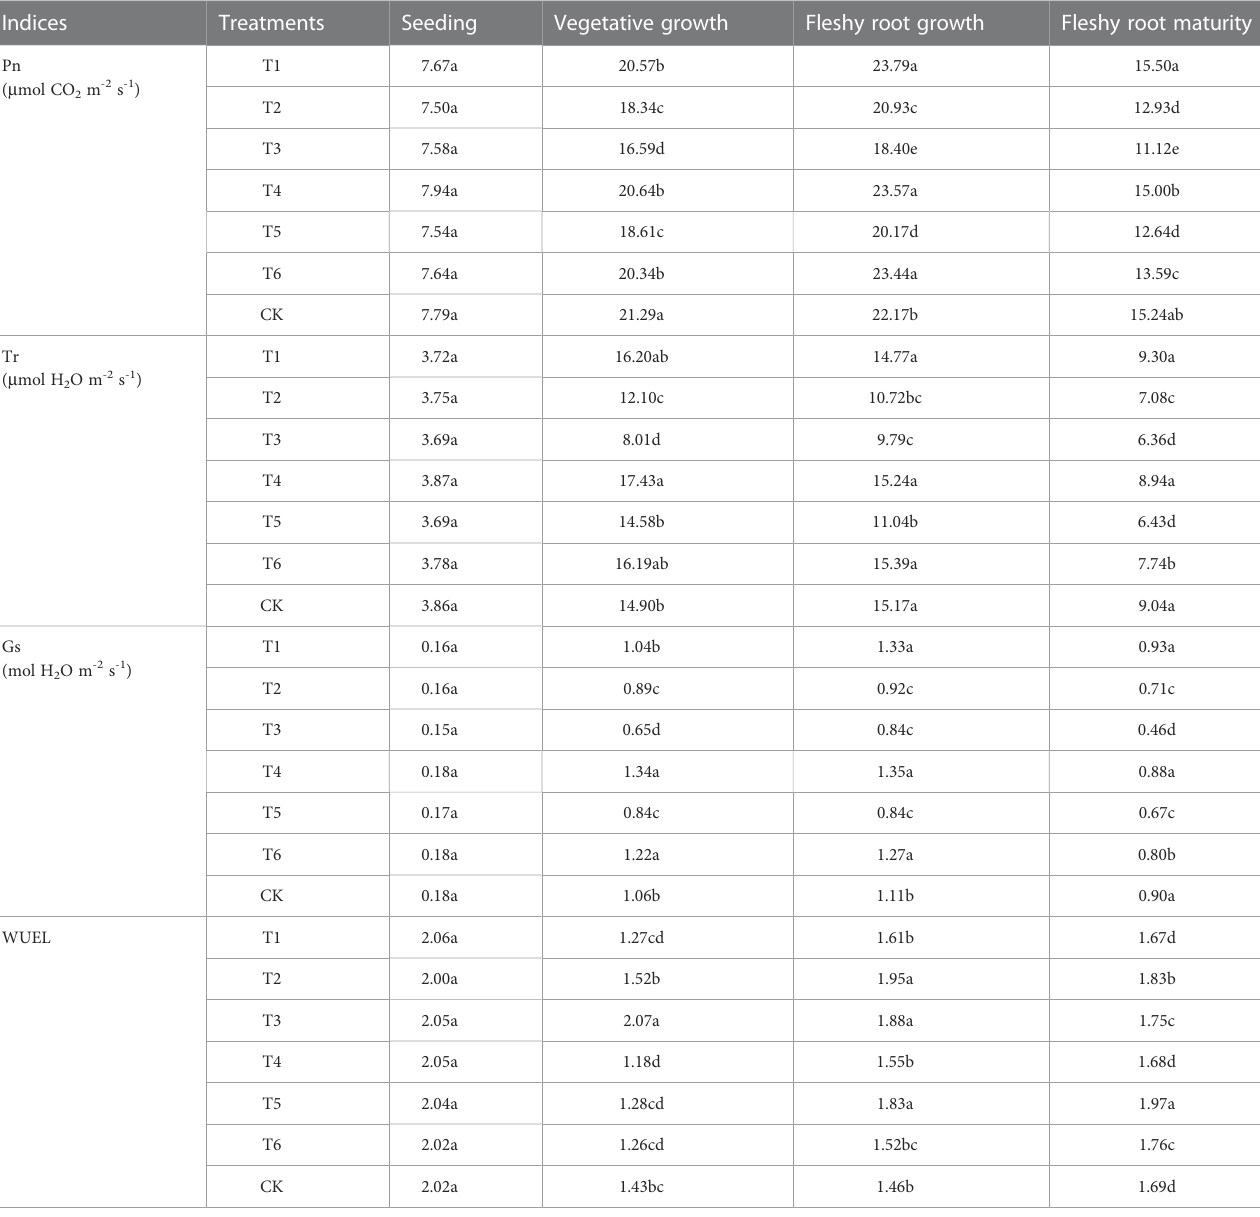
TABLE 3 Effects of different water de fi cits on the Pn, Tr, and Gs of woad leaves. Indices